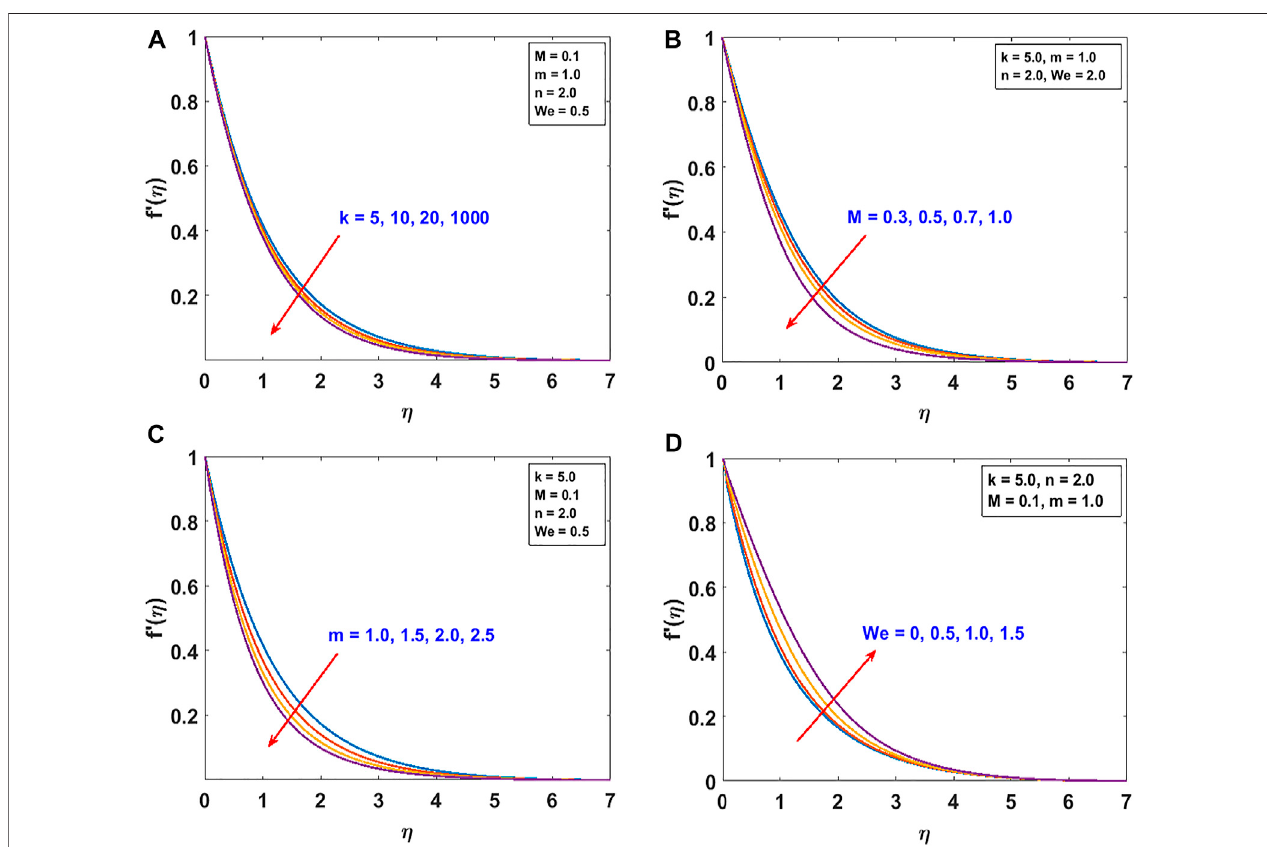
FIGURE 3 | Effect of k, M, m, and We on the